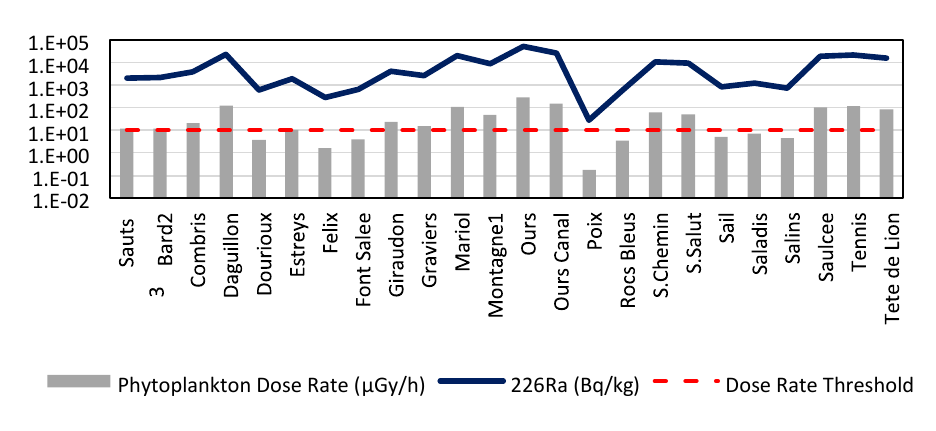
Fig. 2. Radium specific activity in sediments and dose rate for phytoplankton in each spring.